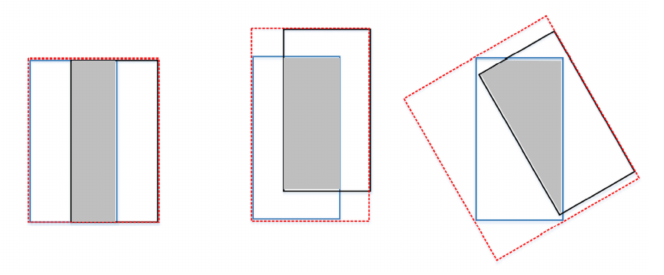
Figure 9. Text detection results with the same IoU